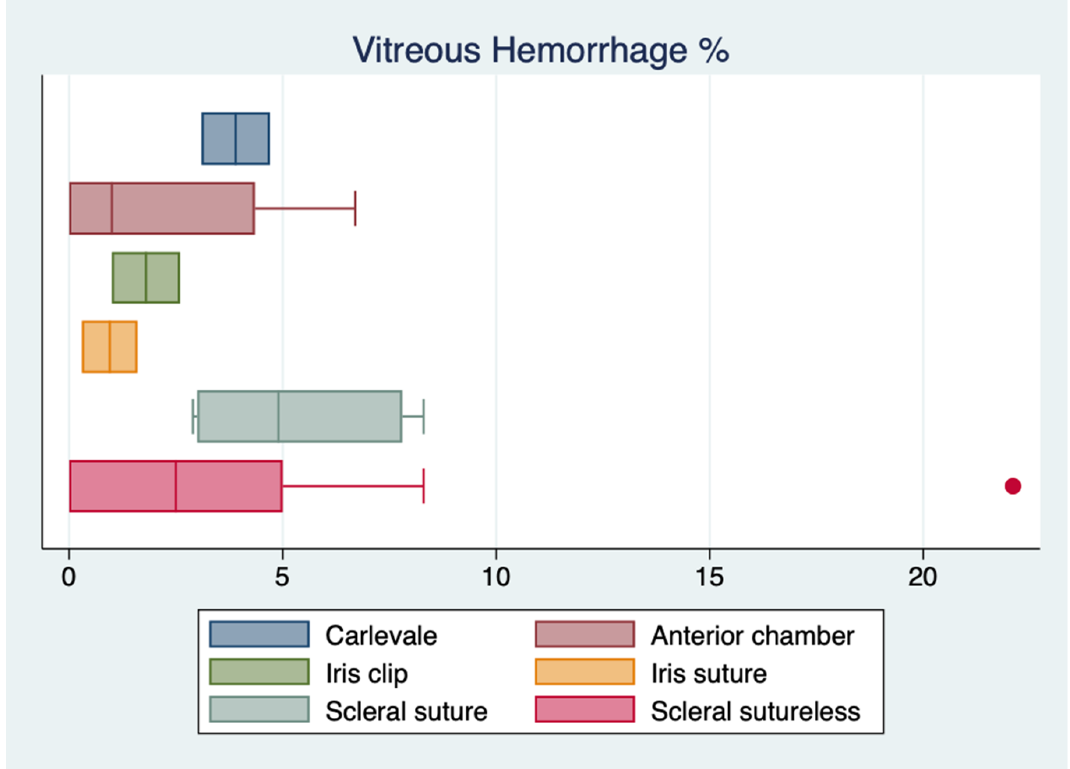
Figure 3. Boxplot of vitreous hemorrhage reported incidences.